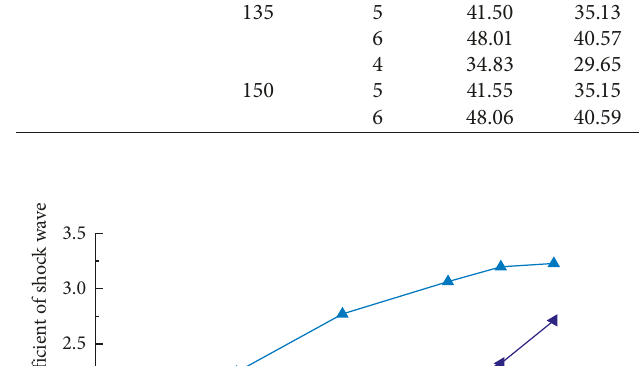
Peak overpressure